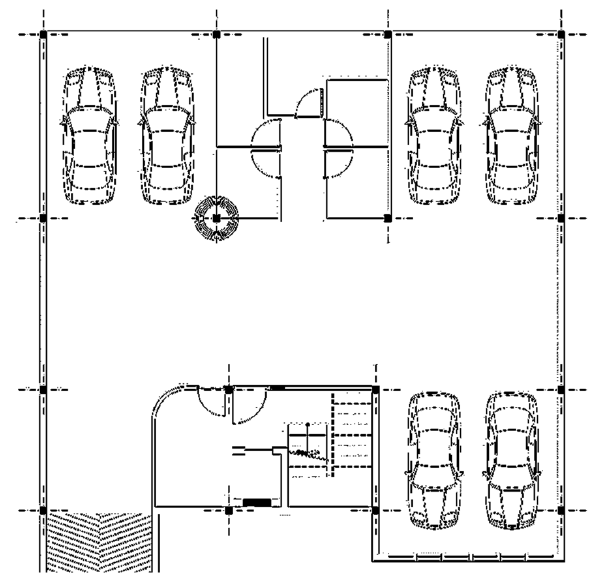
Figure 8. Plan of the building under analysis (the retrofitted column is highlighted with a circle). Table 4. Specifications of materials, cross-section dimensions, and internal actions of the considered column.